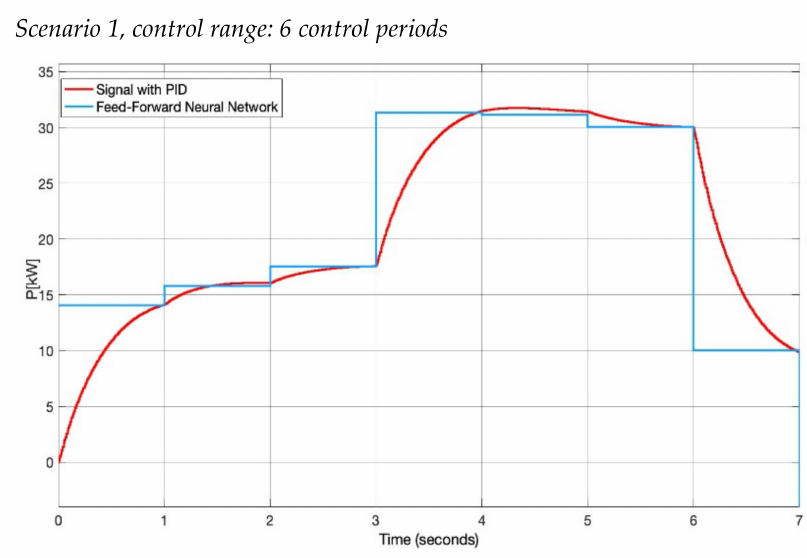
Figure 21. Control signal for BESS, p.f. = 1, SF—weekend.